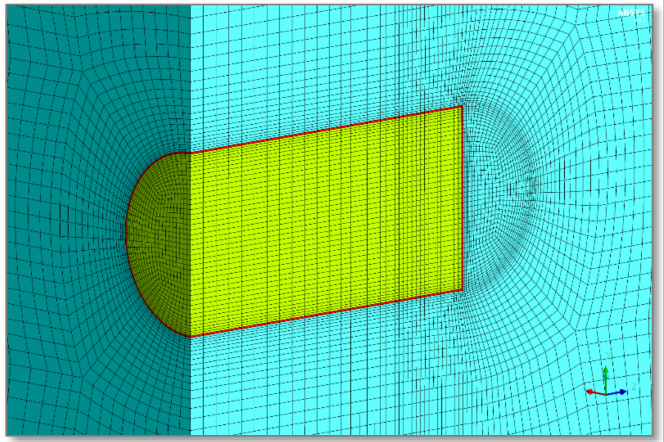
Figure 3. Discretization used in 3D simulations of the particle with L/D =